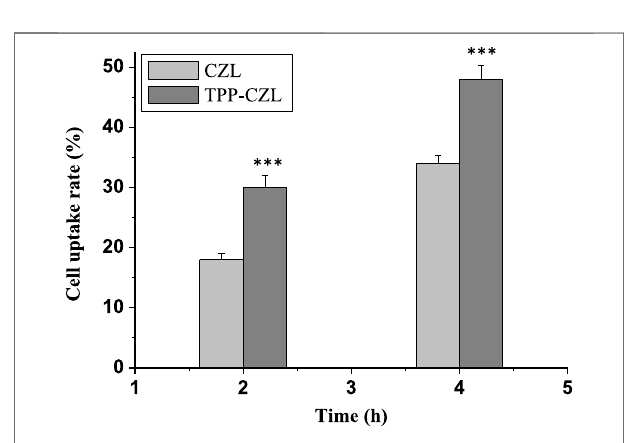
Frontiers in Bioengineering and Biotechnology |